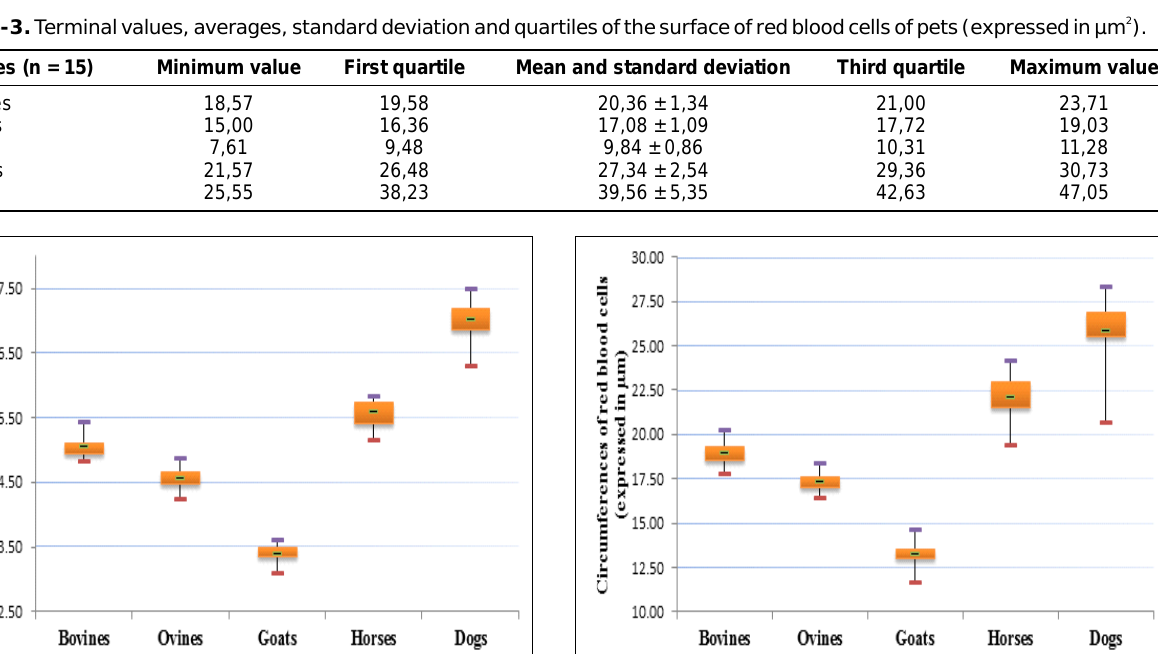
Figure-2. Influence of red blood cells circumference on the determinism of the species of